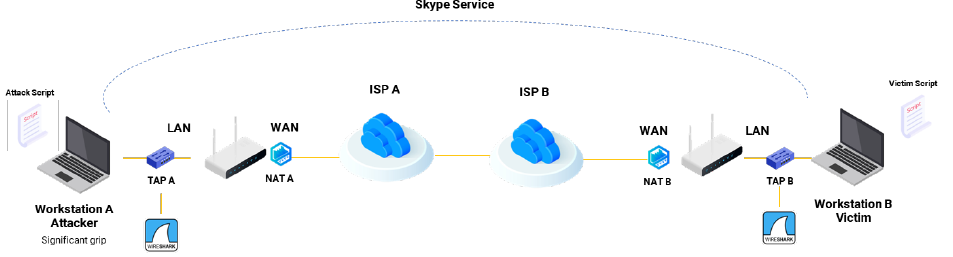
Figure 6. Network architecture of the simulated lab setup; Workstation A and Workstation B act as different organizations separated by different ISPs and NATs. TAP A and TAP B helped monitor traffic as the capture point for the